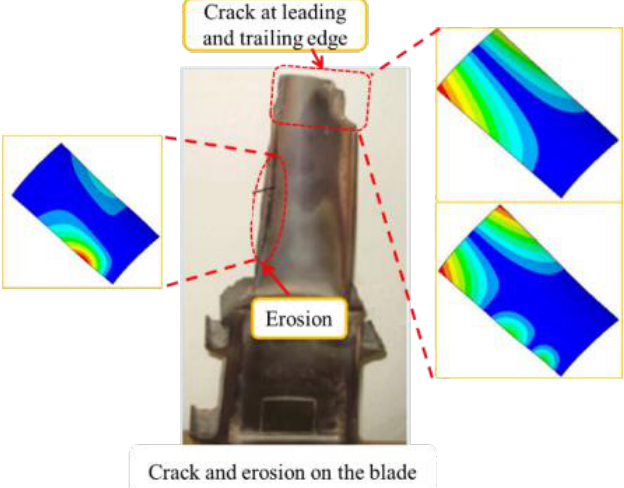
Figure 12. The results comparison of thermal buckling analysis and Ref. [32].